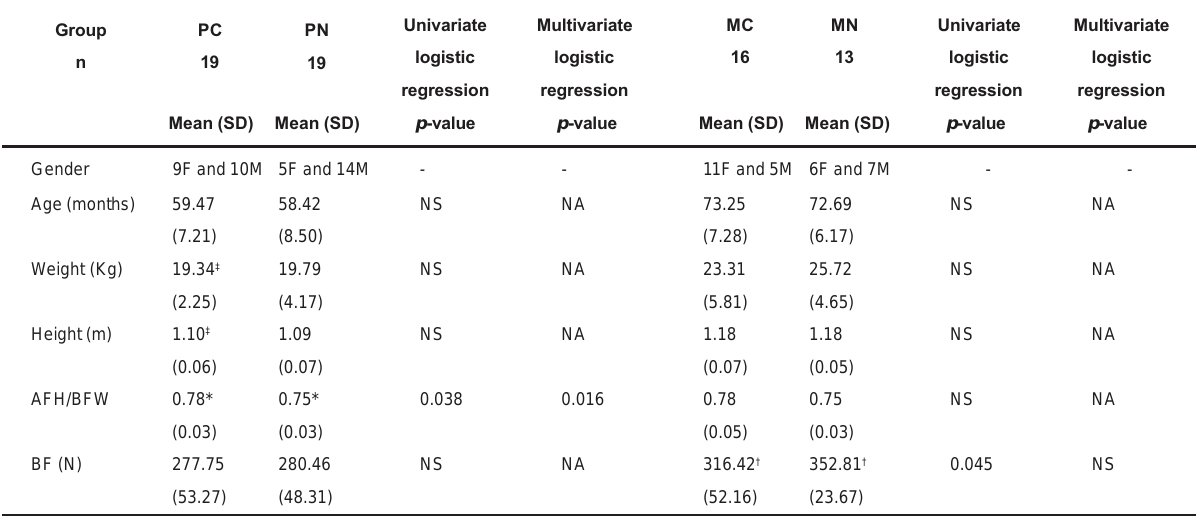
Table 1- Mean (SD) values for age, body variables, facial morphology and maximal bite force (BF) for all groups and the results of statistical